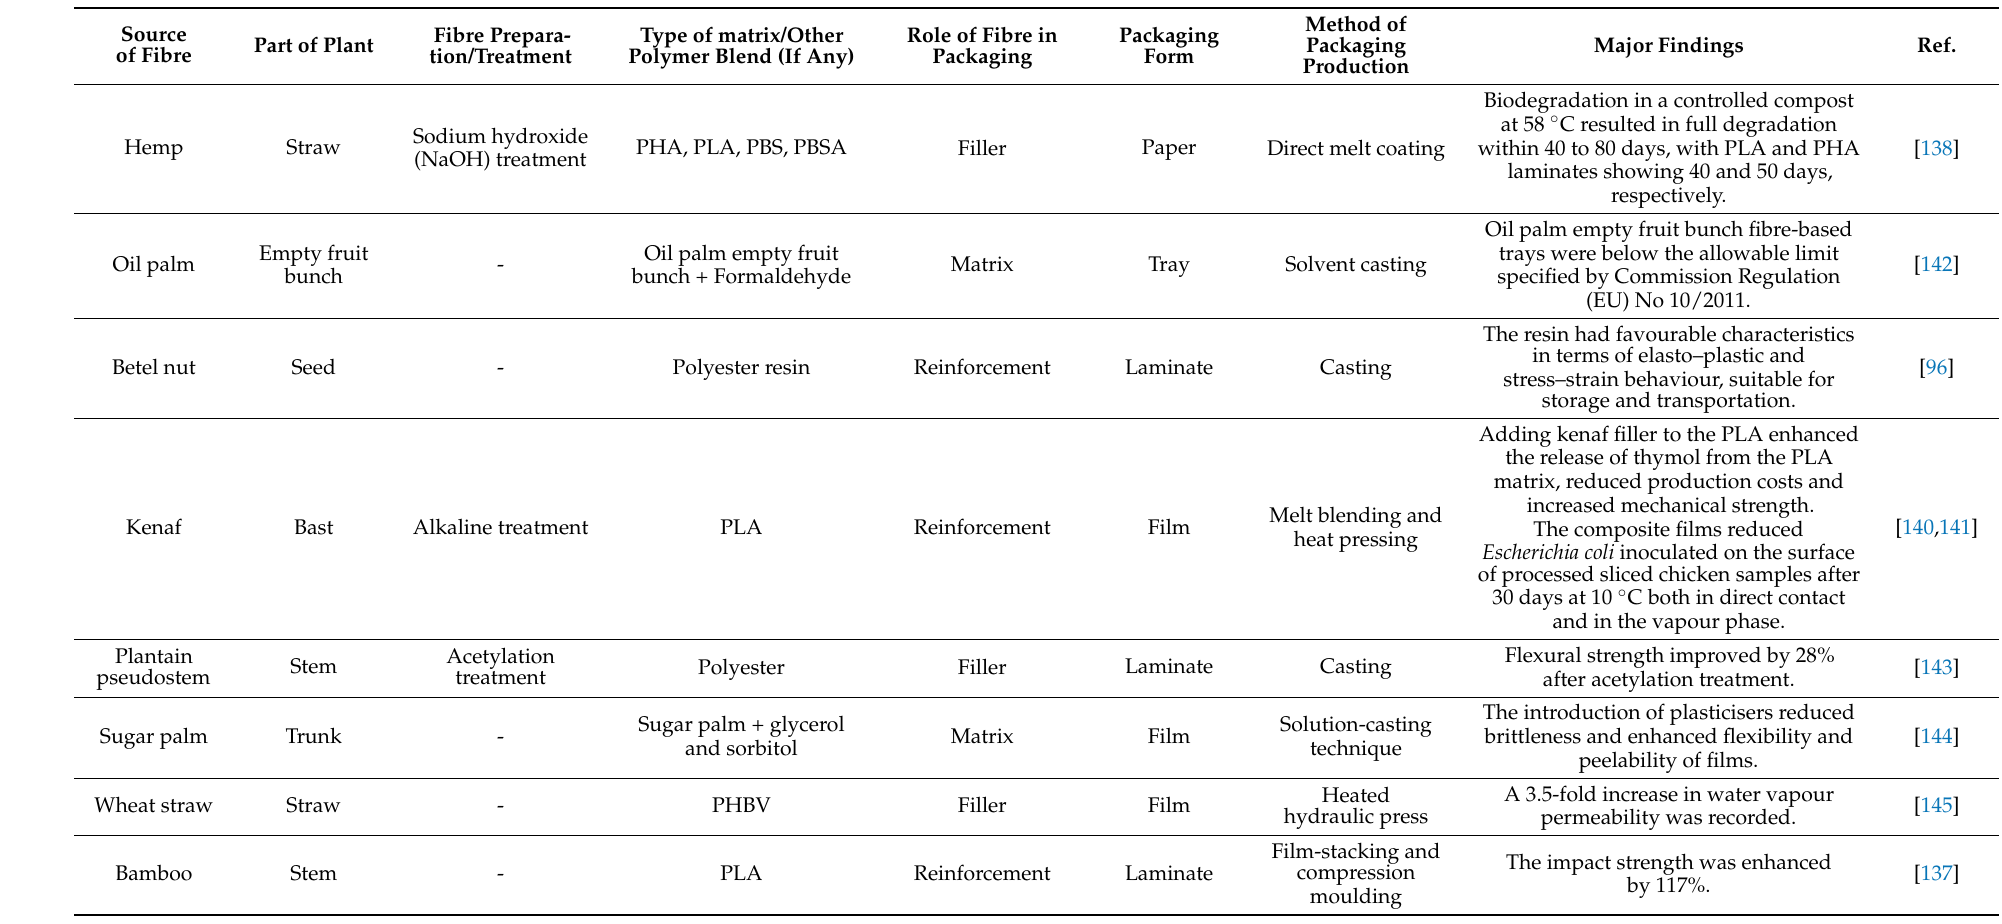
Table 3. Summary of natural fibre-reinforced composites for food packaging